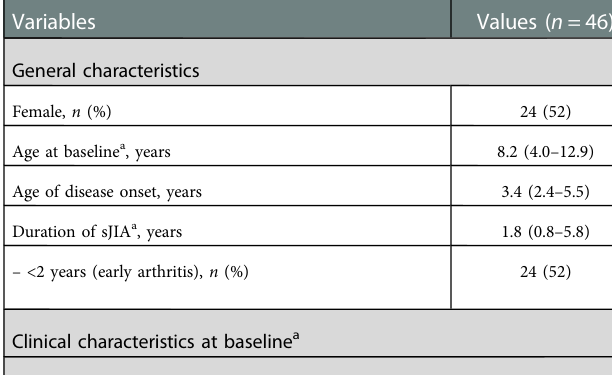
TABLE 1 Patient characteristics at baseline (canakinumab treatment initiation)